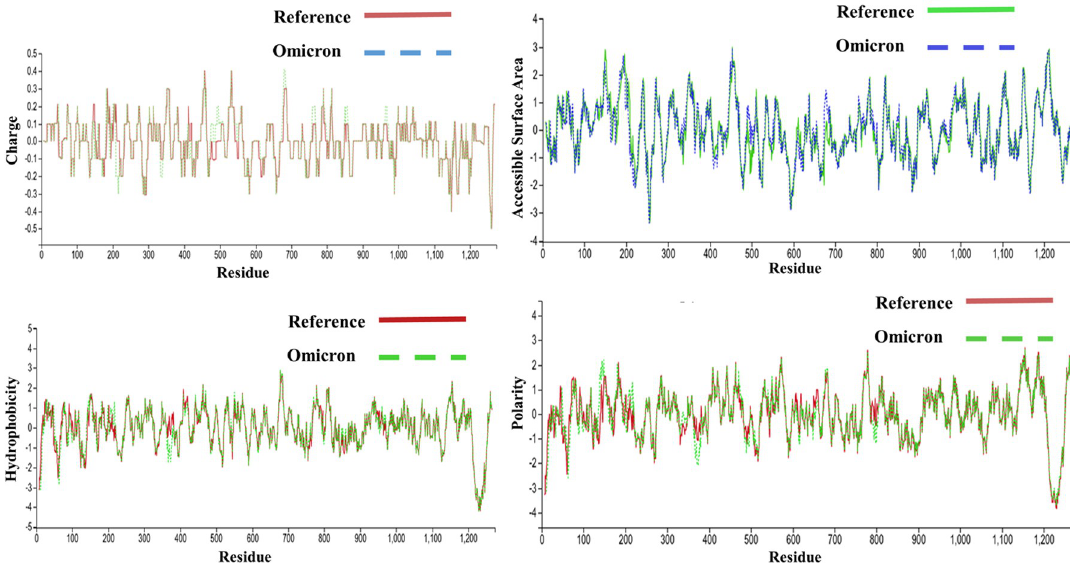
Fig 2. Physicochemical properties of reference variant and Omicron variant spike proteins at the residue level. In every parameter, the receptor binding domain region demonstrated larger fluctuations. A. Variations in electrostatic potential B. Differences in hydrophobicity, C. Variations in the accessible surface area, D. The difference in